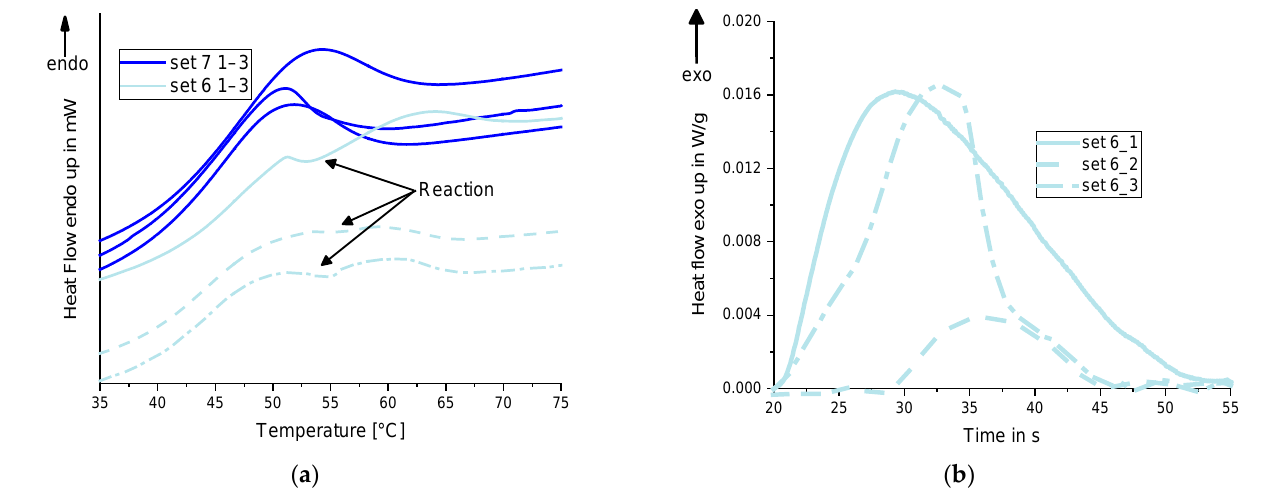
Figure 6. Proof of a post-reaction; ( a ) comparison of the first heat cycle of parameter set 6 and 7; ( b ) exothermic area fraction of the post-reaction to calculate the enthalpy.